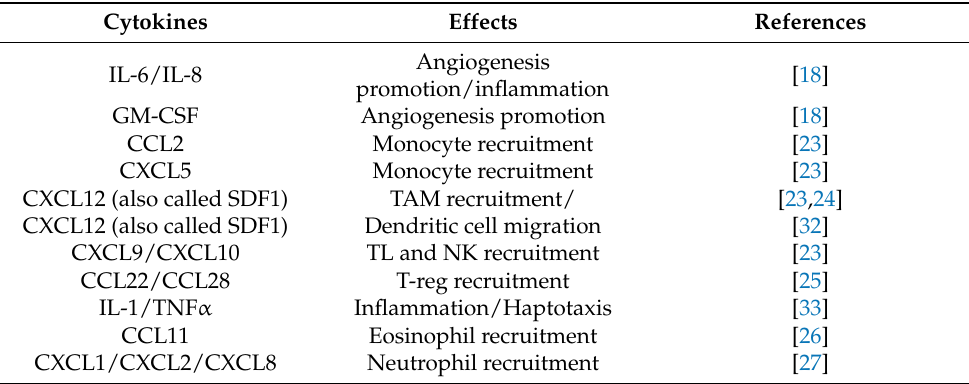
Table 1. An overview of cytokines in the immuno-vascular tumor microenvironment.